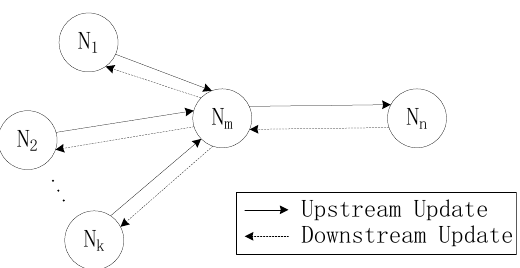
Figure 7. Parameter delivery procedure in